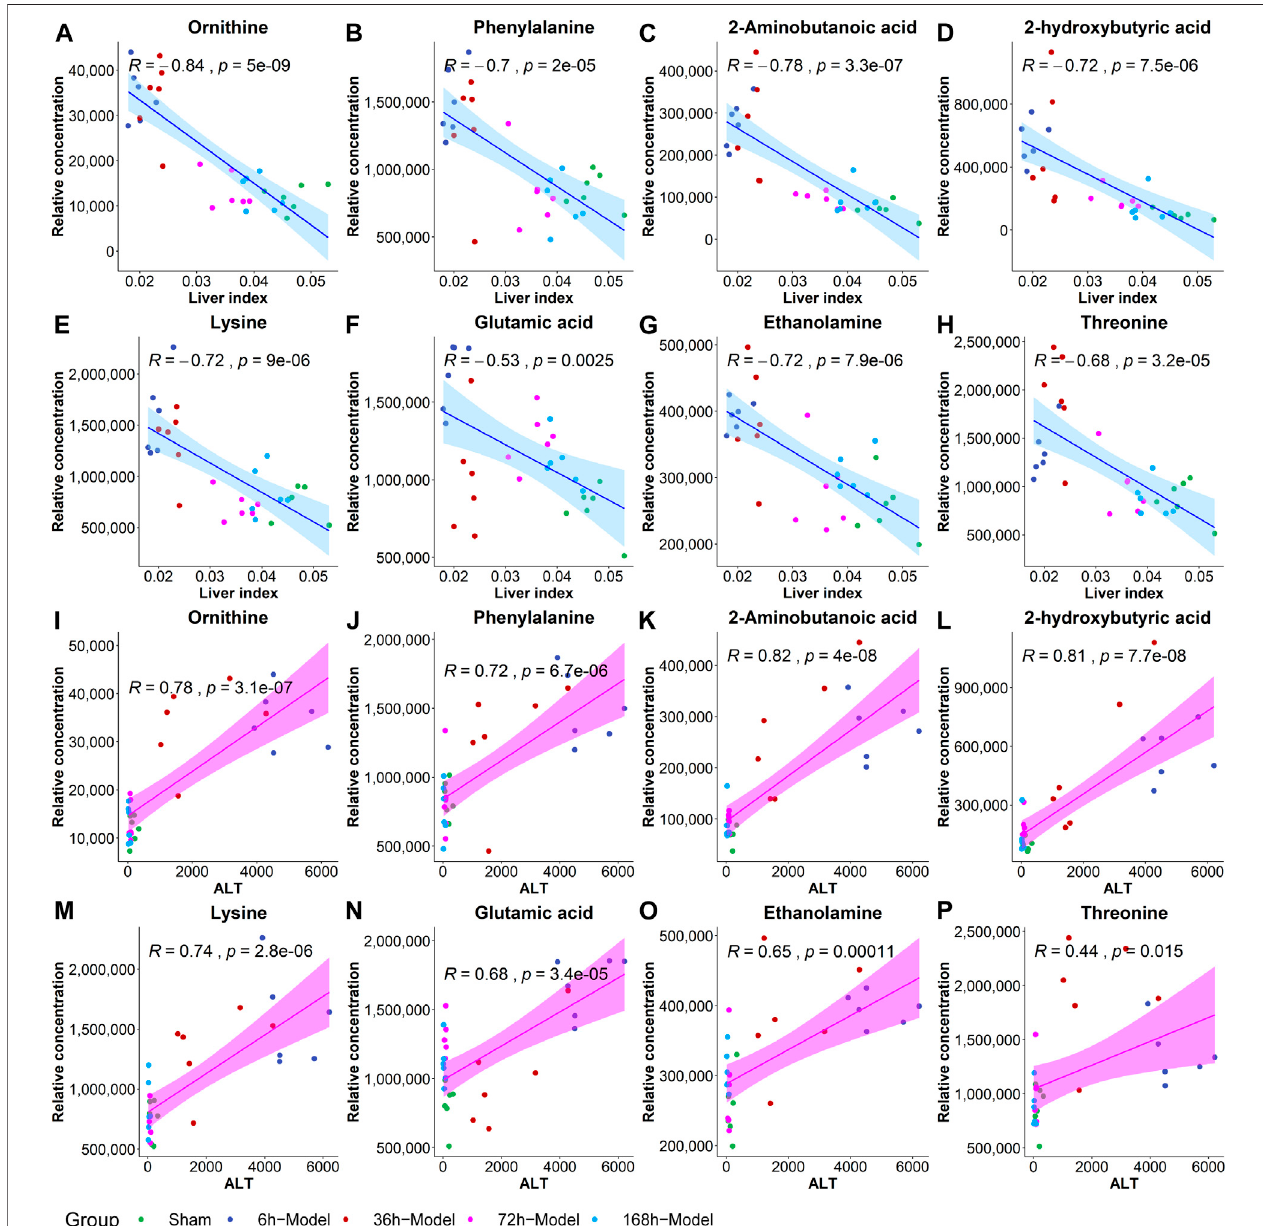
FIGURE 7 | The correlation coef fi cients between the liver index and metabolites including ornithine (A) , phenylalanine (B) , 2-aminobutanoic acid (C) , 2- hydroxybutyric acid (D) , lysine (E) , glutamic acid (F) , ethanolamine (G) and threonine (H) , and the correlations between ALT and metabolites including ornithine (I) , phenylalanine (J) , 2-aminobutanoic acid (K) , 2-hydroxybutyric acid (L) , lysine (M) , glutamic acid (N) , ethanolamine (O) , and threonine (P) .